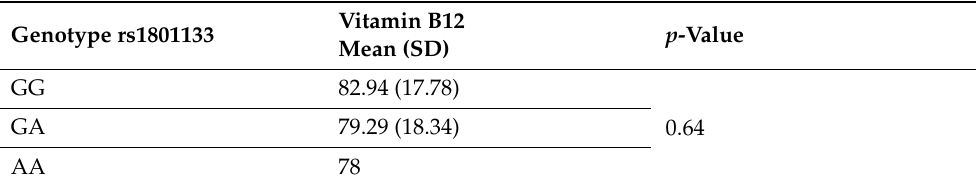
Table 6. The mean vitamin B12 level by MTHFR genotype.